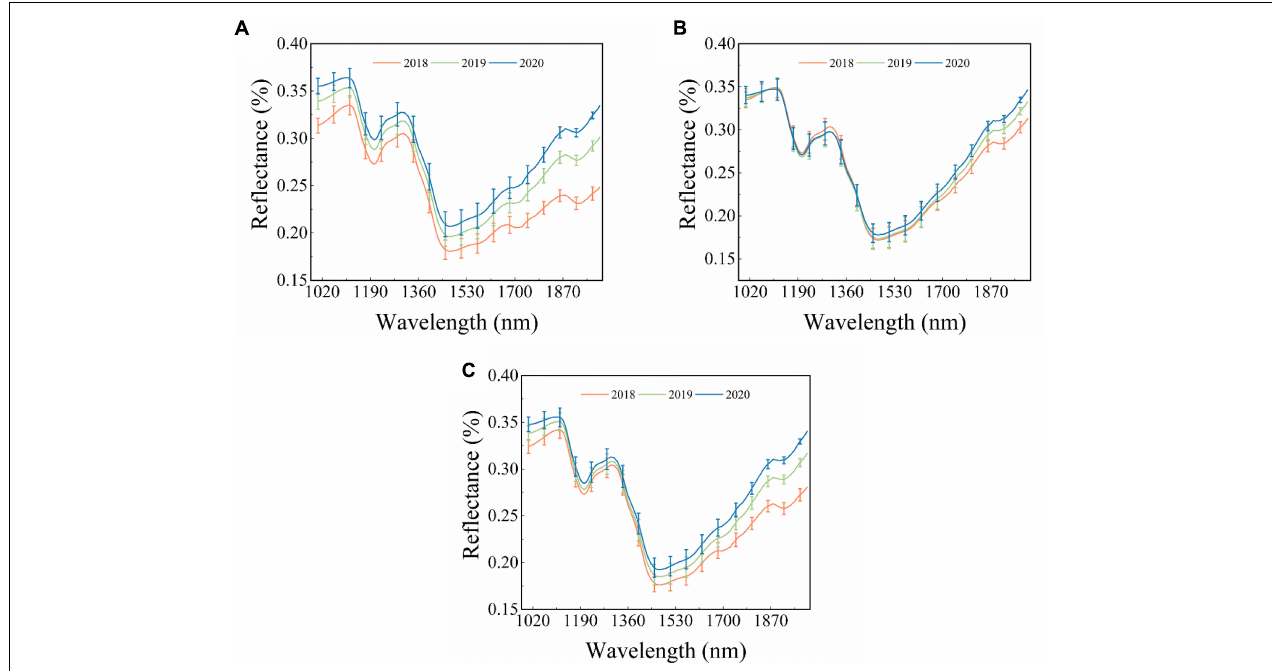
FIGURE 1 | The original reflectance spectra of different sides of single maize seed. (A) Embryo side, (B) endosperm side, and (C) both sides.